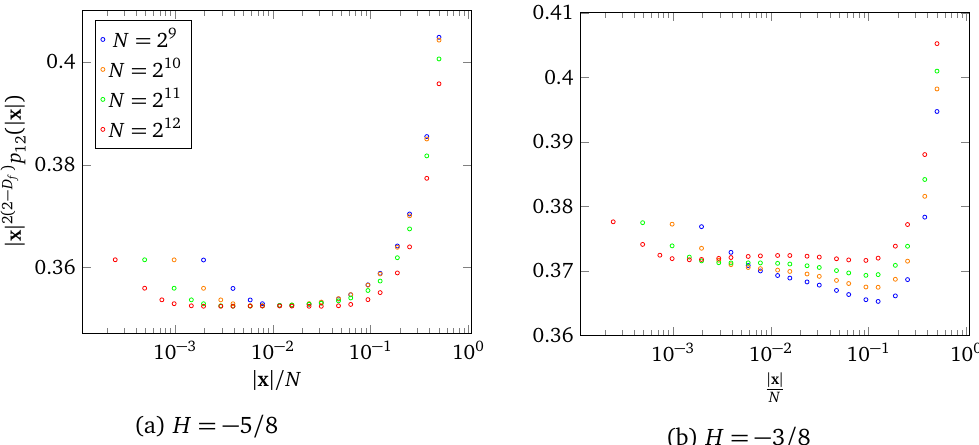
Figure 6: Convergence of the data points generated with surface (48), on the square torus of different sizes, for H = − 5 / 8 (a) and H = − 3 / 8 (b). Error bars are smaller than the marker size and we do not display